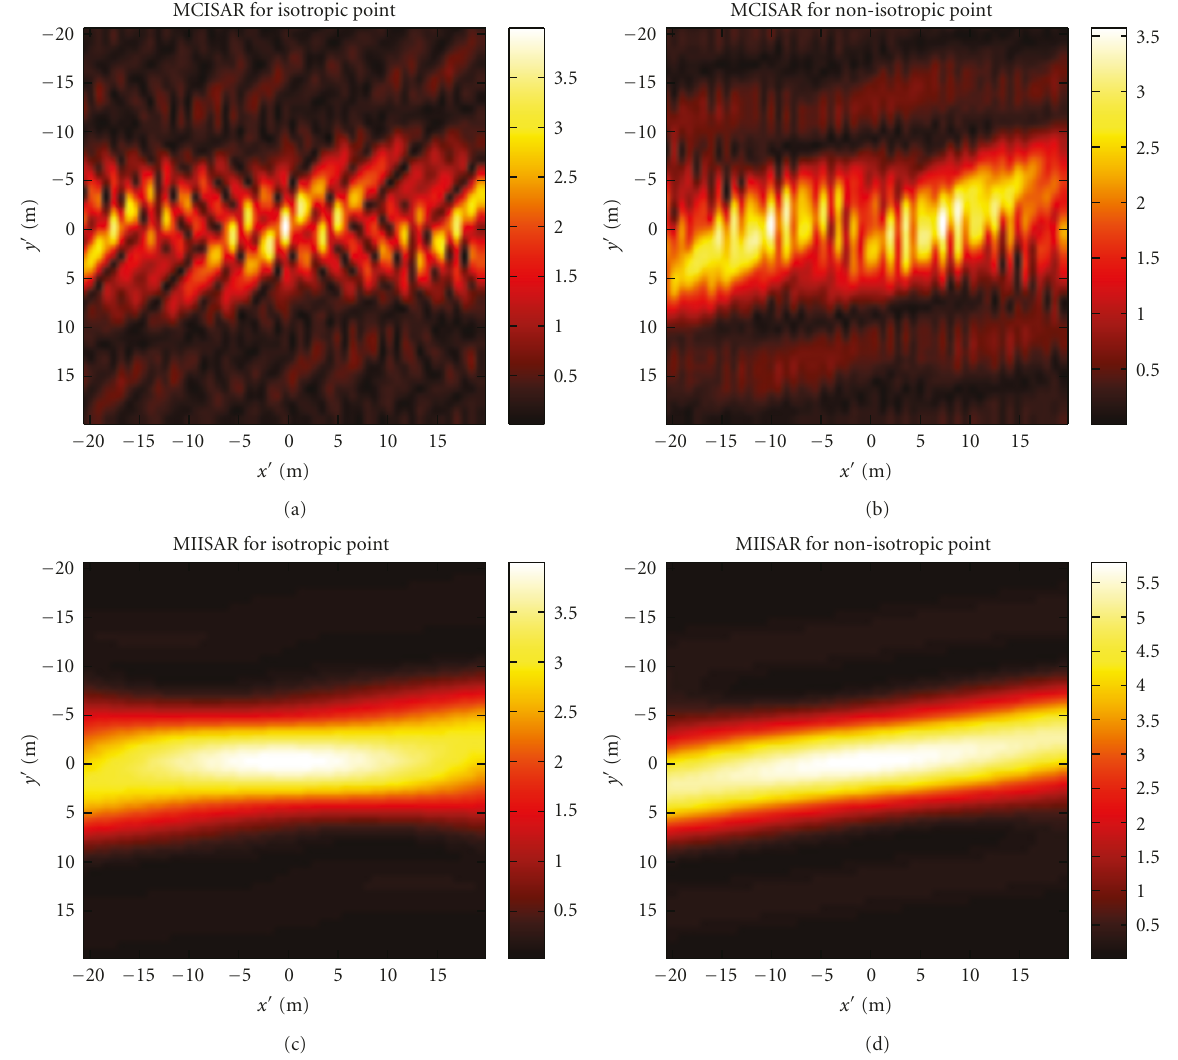
Figure 4: MCISAR result for an isotropic point (a) and nonisotropic point (b) and MIISAR result for an isotropic point (c) and nonisotropic point